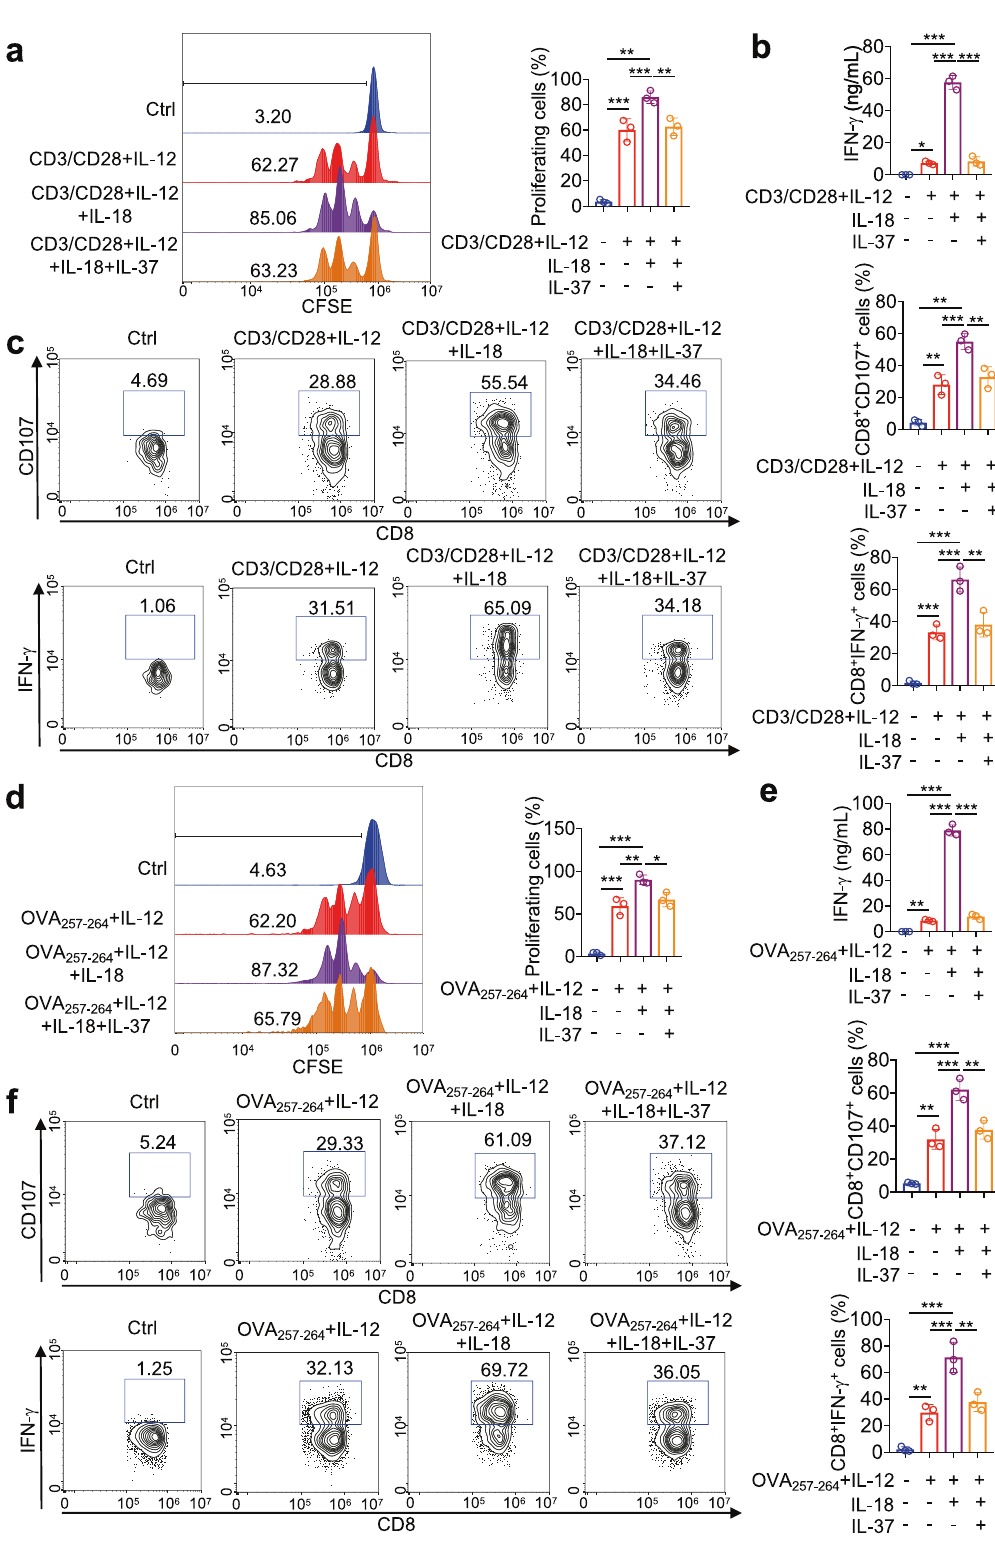
cancer in our study, IL-37 inhibits the in fi ltration of immune cells, such as CD8 + T cells and macrophage, in the intestine. Compared with the previous transgenic mouse by McNamee et al., con- structed IL-37tg mice in our study exhibit different expression patterns, especially overexpression of IL-37 in colonic tissue. This